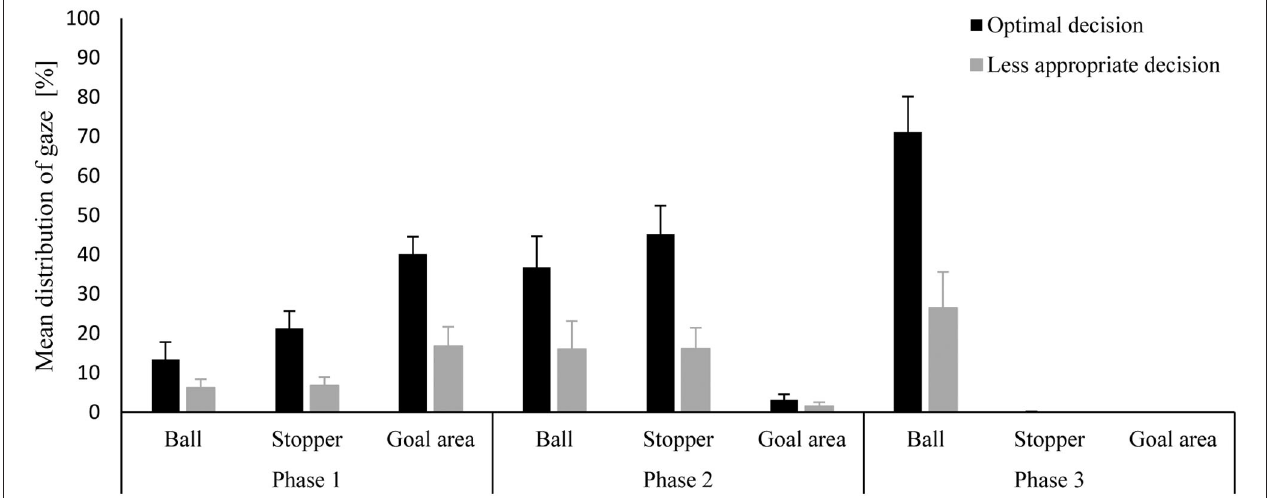
FIGURE 6 | Mean distribution (and SD) of gaze duration at the areas of interest (ball, stopper, goal area) for the evaluation of how well an offensive strategy has matched the run-out of defenders (optimal; less appropriate) as a function of time (Phase 1, Phase 2; Phase 3) and in relation to the length of a